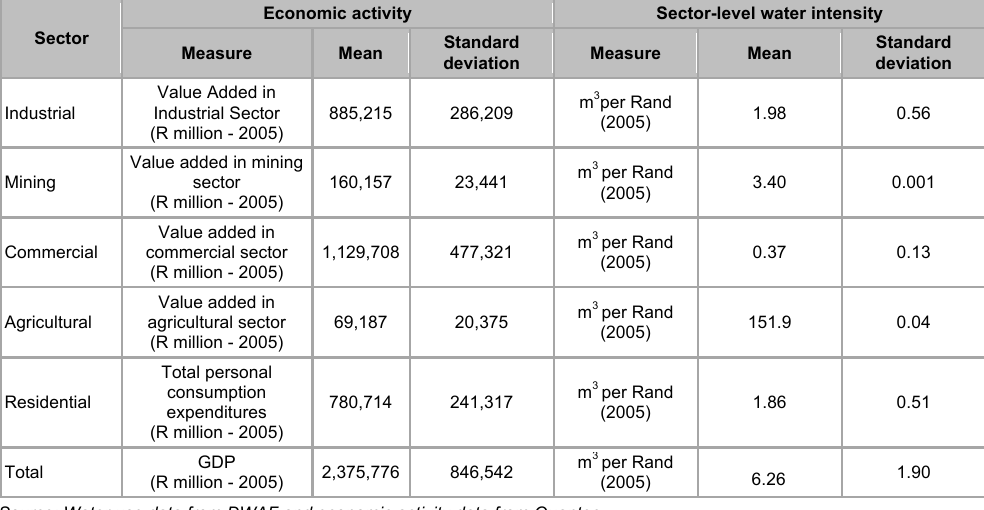
South African economic activities for the national level decomposition analysis